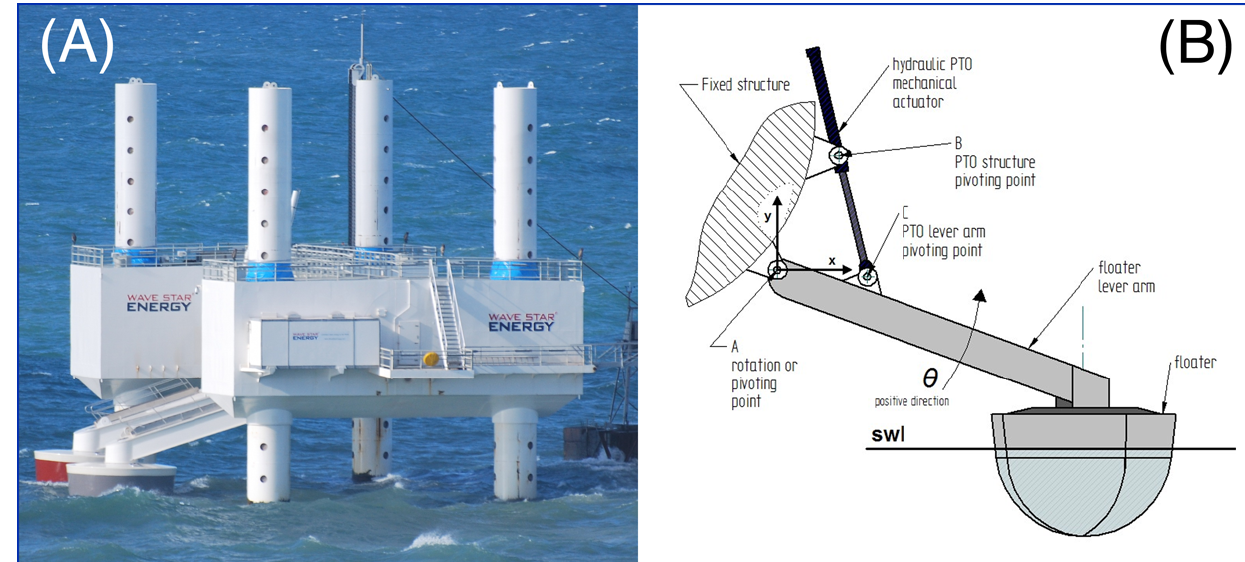
Figure 2. ( A ) Wavestar prototype at Hanstholm (Denmark); and ( B ) sketch of floater details with main components and coordinate system.